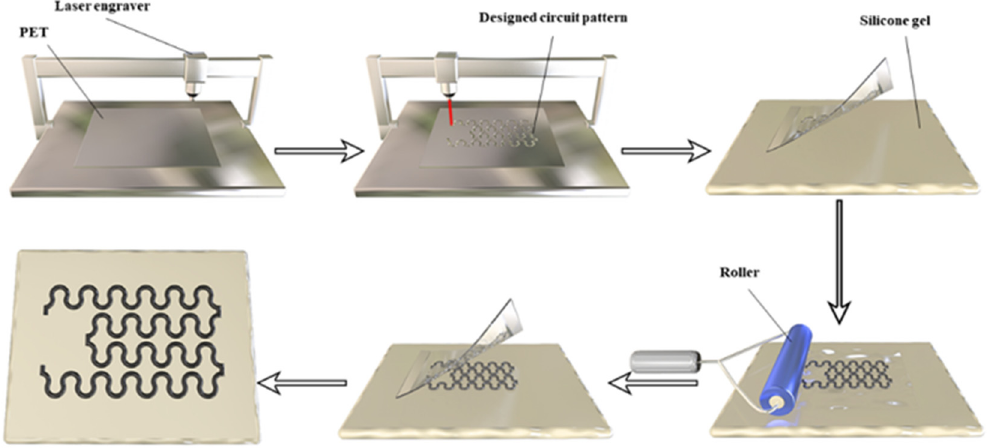
Figure 1. The flow chart of the Direct Printing Using Laser Engraved Masks (DPULEM) method.